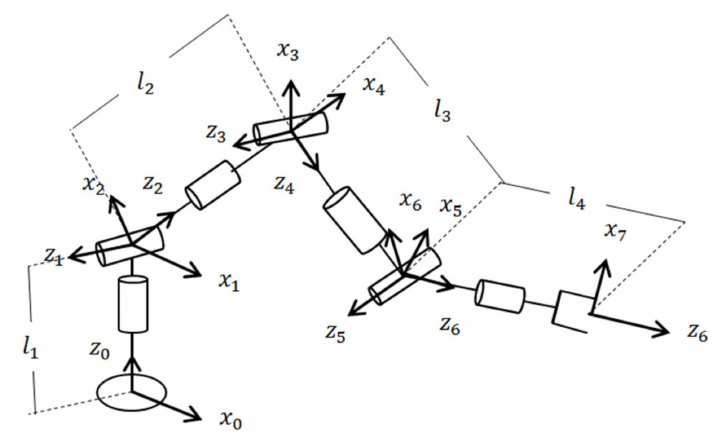
Figure 1. Structure of the manipulator